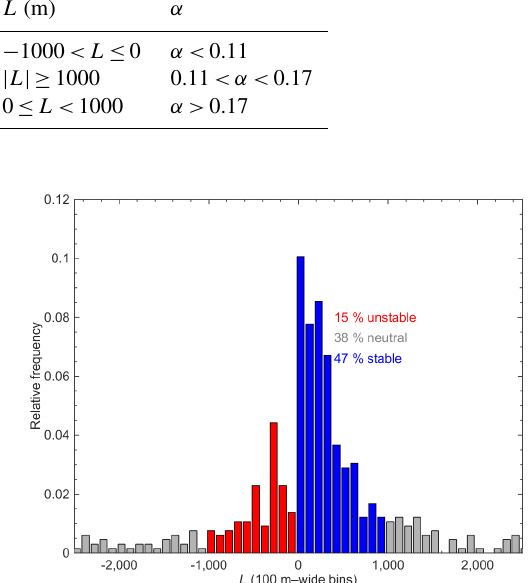
Figure 9. R B distribution using thresholds in Table 2, includ- ing data filtered for tower 80m wind speeds between 3.5 and 25.0ms − 1 , 87m wind directions between 235 and 315 ◦ , and for normal turbine operation.